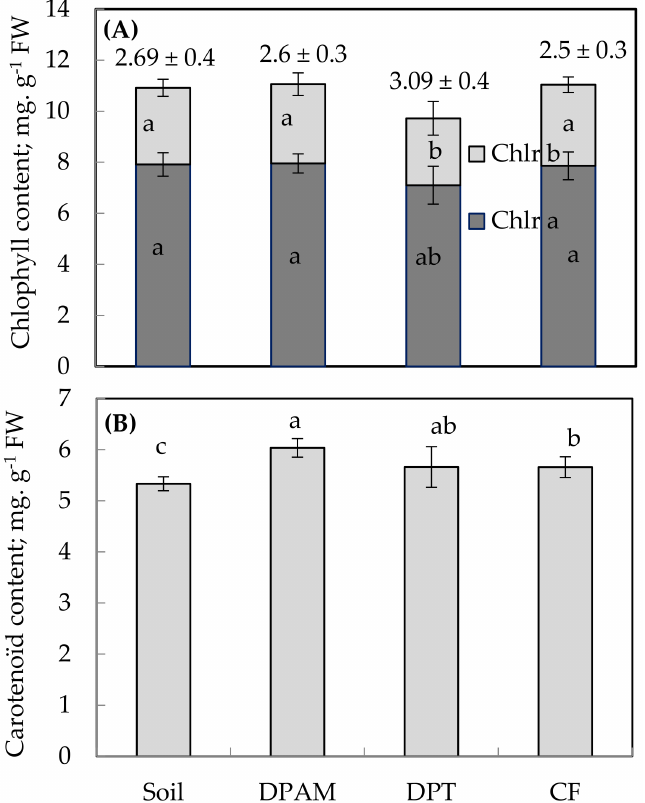
Figure 2. Variation in assimilating pigments content (mg g − 1 FW) in leaves of 5 months old melon plants cultivated on different substrates. DPAM: compost of date palm residues and animal manure; DPT: compost of datepalm trunk; CF: coconut fiber, compared with soil substrate. ( A ) chlorophylls ( B ) carotenoids. Numbers in histograms correspond to the chlr a/b ratio. Results are the means of six replicates ± SD. Vertical bars indicate standard errors of